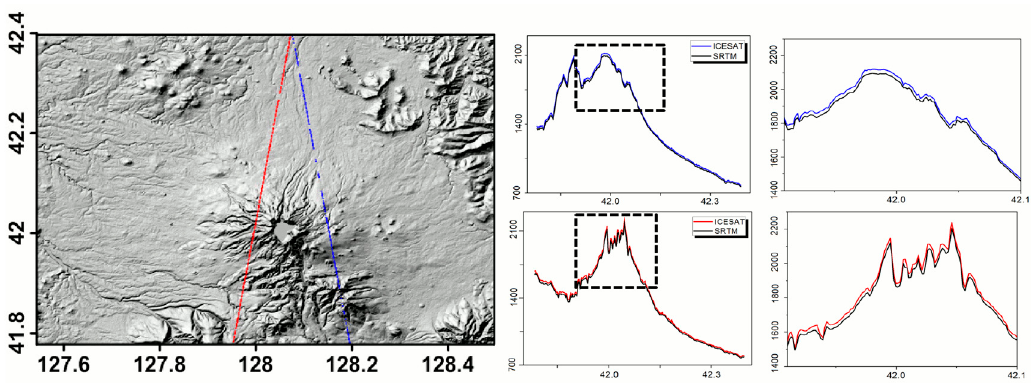
Figure 9. ICESAT Track profiles over Mt. Baekdu. The mean and standard deviation values of height difference (ICESAT-SRTM DTM) along ICESAT track 2008/03/05 (red line) are 18.892 m and 5.741 m respectively. Along the ICESAT track 2008/03/17 (blue line), the mean and standard deviation of height difference are 19.432 m and 7.932 m.